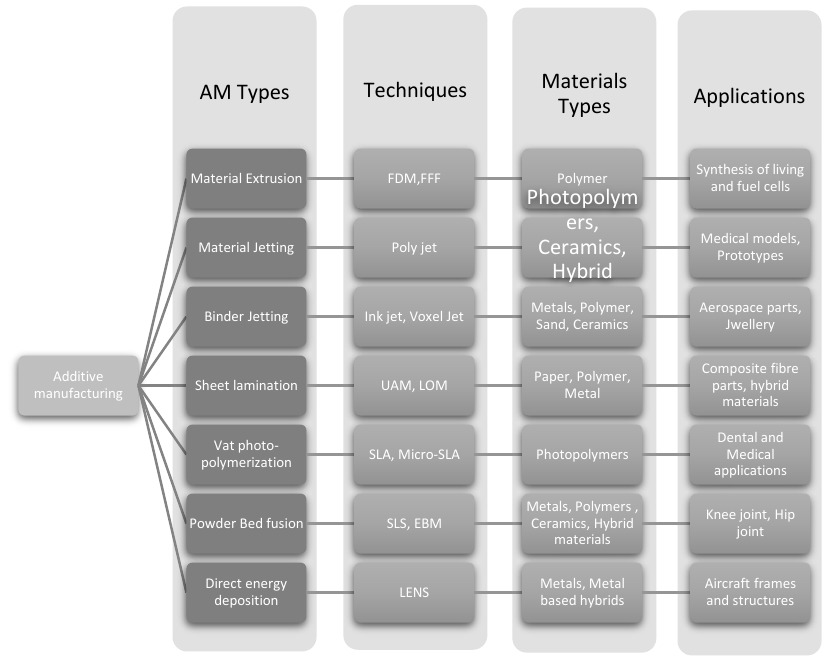
Figure 8. The additive manufacturing process and